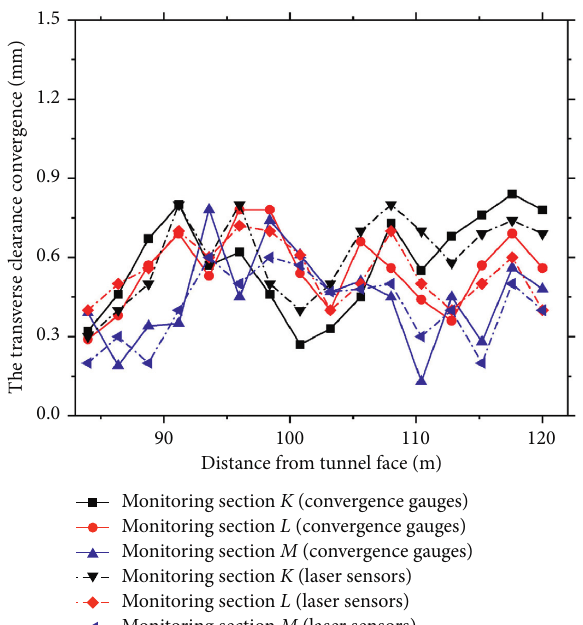
Figure 6: Comparison between traditional monitoring method and WSN on tunnel lateral clearance convergence.